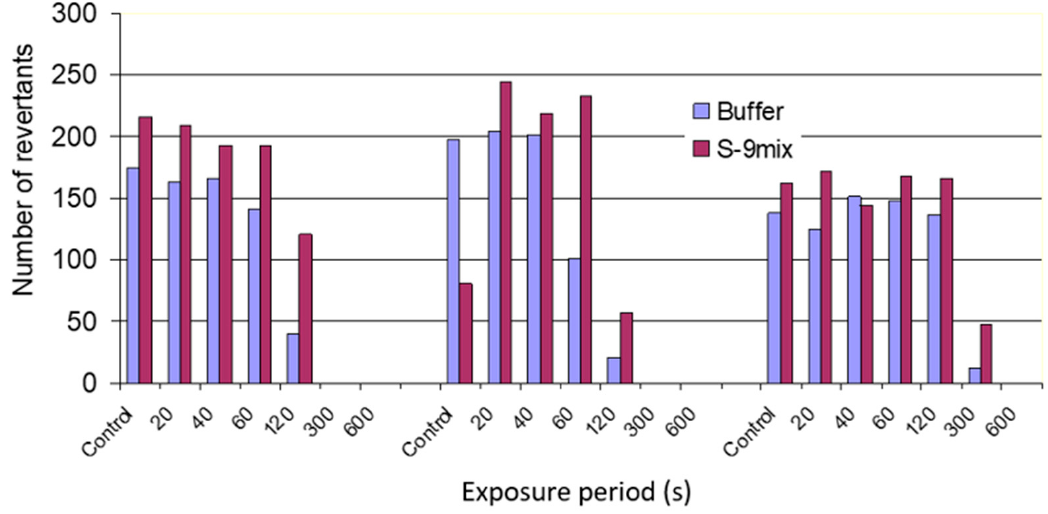
Figure 2. Number of TA97 strain revertant colonies observed after exposure to vapors. Table 1. Relative antibacterial activities of vegetable oil esters and fog oil aerosols. Methyl Ester/Oil Methyl Soyate Fog